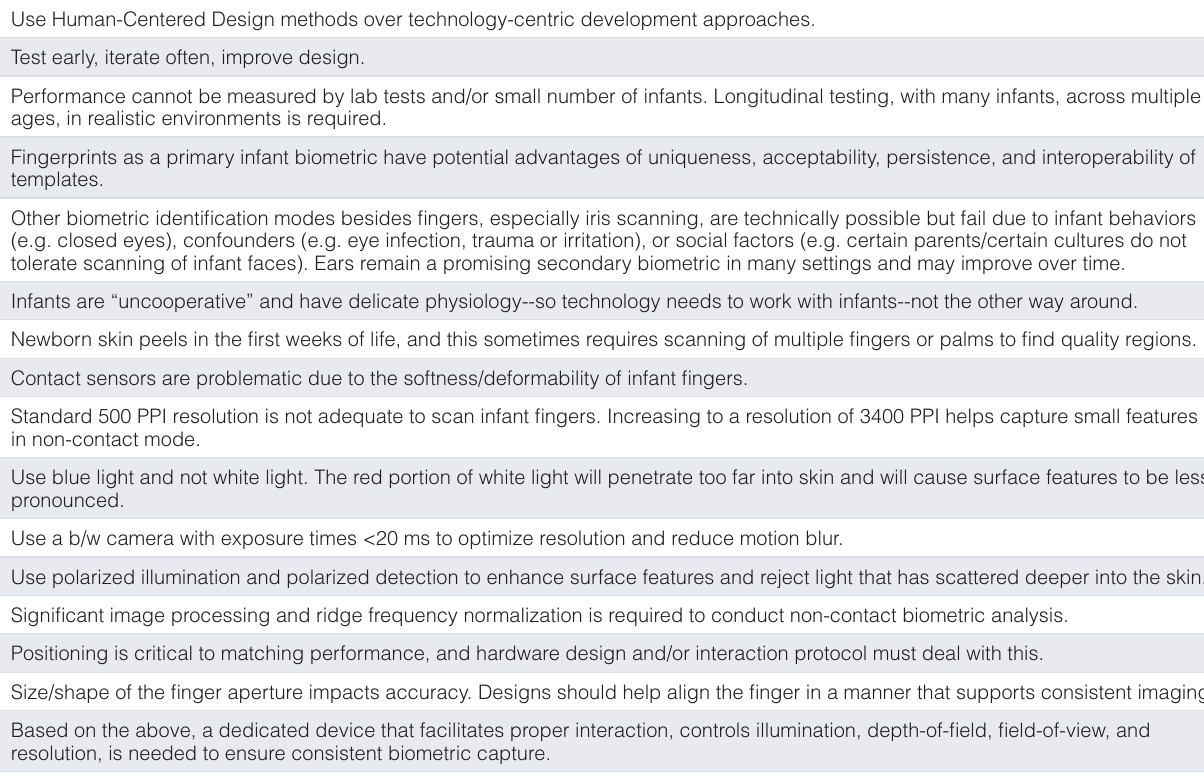
Table 1. Summary of Lessons